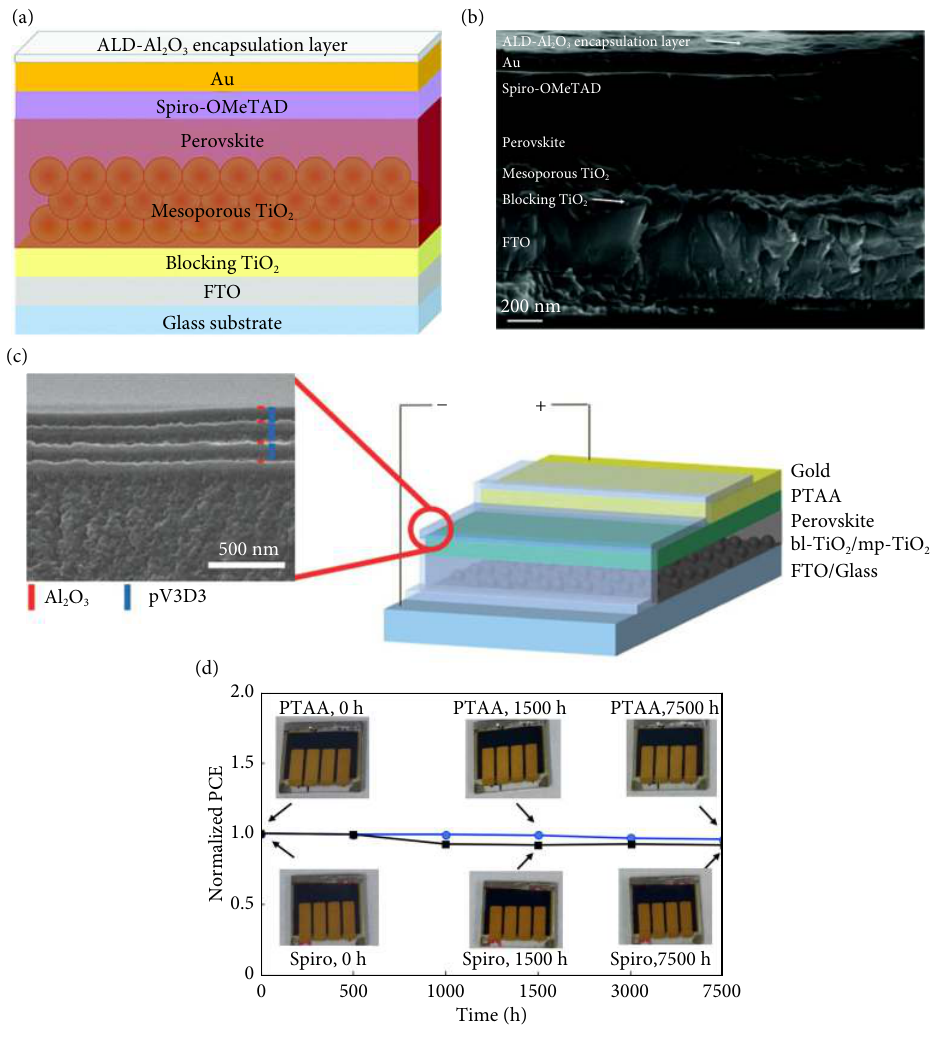
Fig. 6 ALD for thin-film encapsulation. ( a and b ) Schematic and cross-sectional SEM images of PSCs with the ALD–Al 2 O 3 encapsulation layer (reprinted with per- mission from ref. [78], © 2018 The Royal Society of Chemistry). (c) Schematic illustration of the encapsulated PSC and the cross-sectional SEM image of the composite encapsulation (reprinted with permission from ref. [79], © 2017 Wiley VCH). (d) Long-term stability of PSCs with 50 nm Al 2 O 3 as encapsulation. The PSCs were stored at room temperature (dark) in 50% RH for 7500 h (reprinted with permission from ref. [77], © 2018 Elsevier